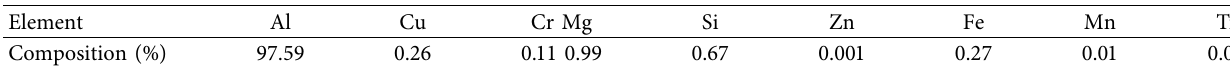
Table 2: Chemical composition of AISI 304.